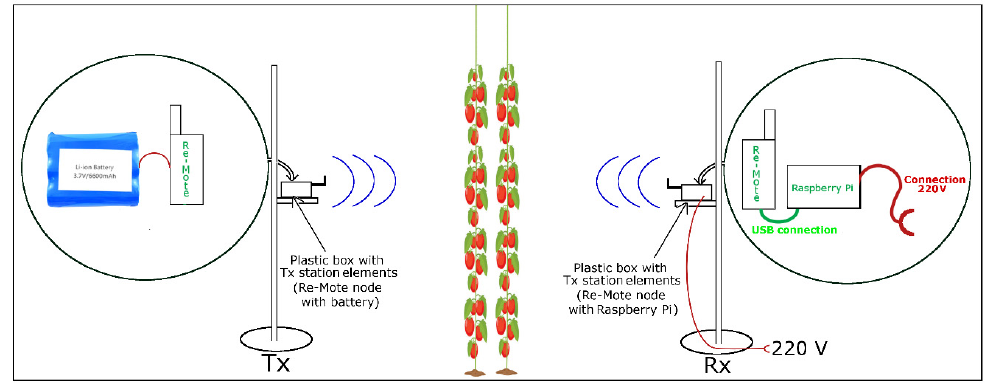
Figure 2. Deployment of the two Tx and Rx stations communicating wirelessly in a cross section of a tomato greenhouse.